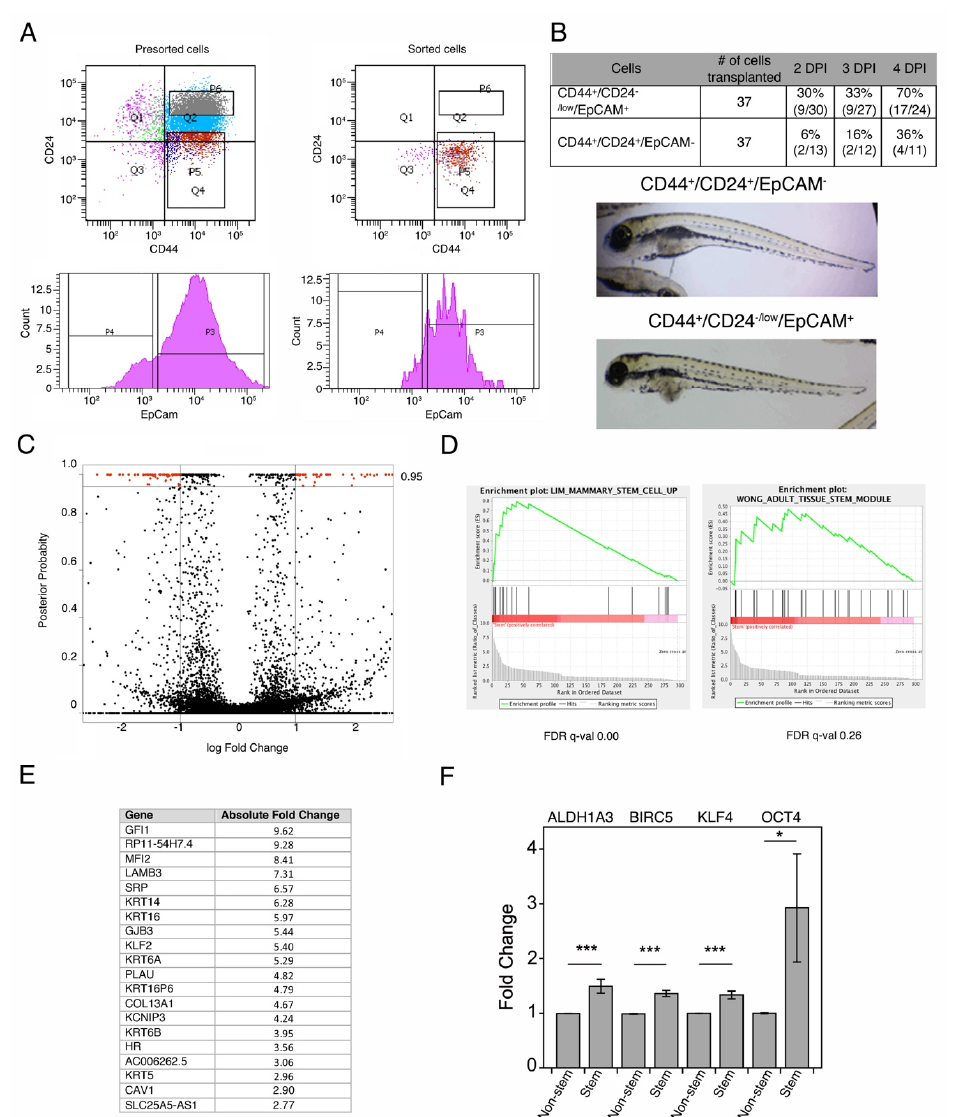
Figure 1. Isolation of Cancer Stem Cells. ( A ) Left panels: Flow cytometry analysis of MDA-MB-468 cells previous to sorting. The upper panel shows a dot plot with the fluorescence intensity of CD44 versus CD24 and the selected fields for sorting (CD44 high and CD24 low). The lower panel shows the third used marker (EpCam). Right panels: These plots display the purified population obtained after sorting. ( B ) Tumorigenicity assays using a zebrafish xenotransplant model. Upper panel: Tumor developed by MDA-MB-468 non-Cancer Stem Cells (CSCs; CD44 + CD24 + EpCAM - ) and CSCs (CD44 + CD24 −/low EpCAM + ) at 2, 3 and 4 DPI (Days Post Injection). For each experiment, 30 embryos were used and only informative (e.g., surviving) embryos were assessed. #: The number of cells transplanted to the embryos. Lower panel: Representative image taken at 2 DPI, showing abdominal tumors (arrows) in zebrafish embryos transplanted with MDA-MB-468 non-CSCs and MDA-MB-468 CSCs. ( C ) Volcano plot showing DE significant genes in red (posterior probability of being differentially expressed > 95%). The line shows the cutoff for significance. ( D ) GSEA analysis of the DE genes found. Left panel: Enrichment against a mammary stem cells signature (derived from [17]). Right panel: Enrichment against a tissue stem cell signature (derived from [18]). ( E ) Top 20 DE genes with a False Discovery Rate < 0.05. ( F ) Absolute fold change of representative genes in CD44 + CD24 − / low EpCAM + (Stem) cells versus CD44 + CD24 + EpCAM - (Non-stem) cells analyzed by qRT-PCR. Data derived from three independent FACS isolation experiments; * p < 0.05; *** p <